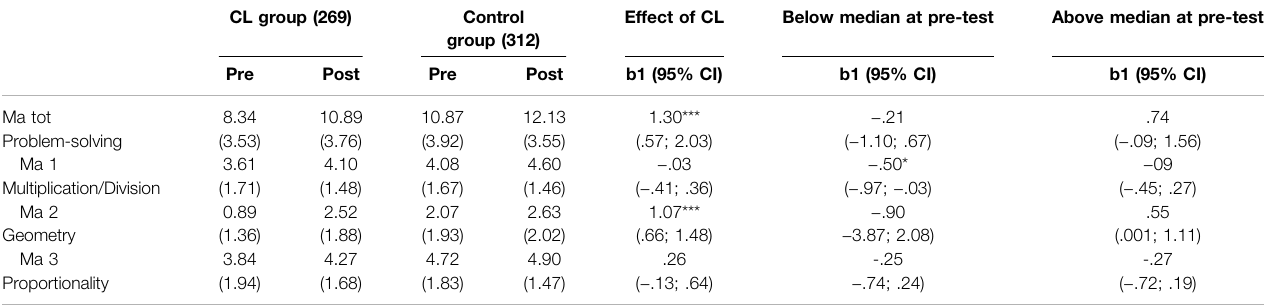
TABLE 2 | Mean scores (standard deviation in parentheses) and unstandardized multilevel regression estimates for tests of mathematical problem-solving. CL group (269) Control Effect of CL Below median at pre-test Above median at group (312)